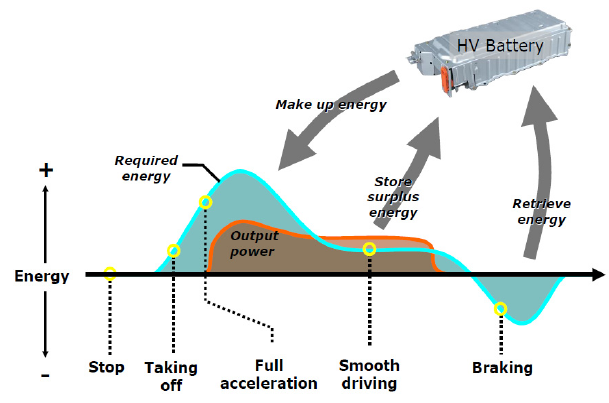
Figure 9. The high performance of the hybrid system. Source